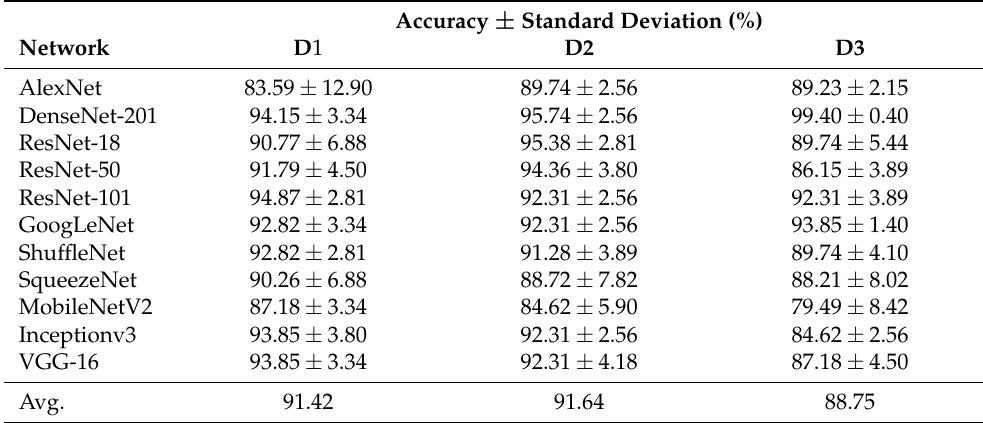
Table 3. Average accuracy and standard deviation computed on the same test set, after training with 100, 200 and 300 images (D1, D2, D3,